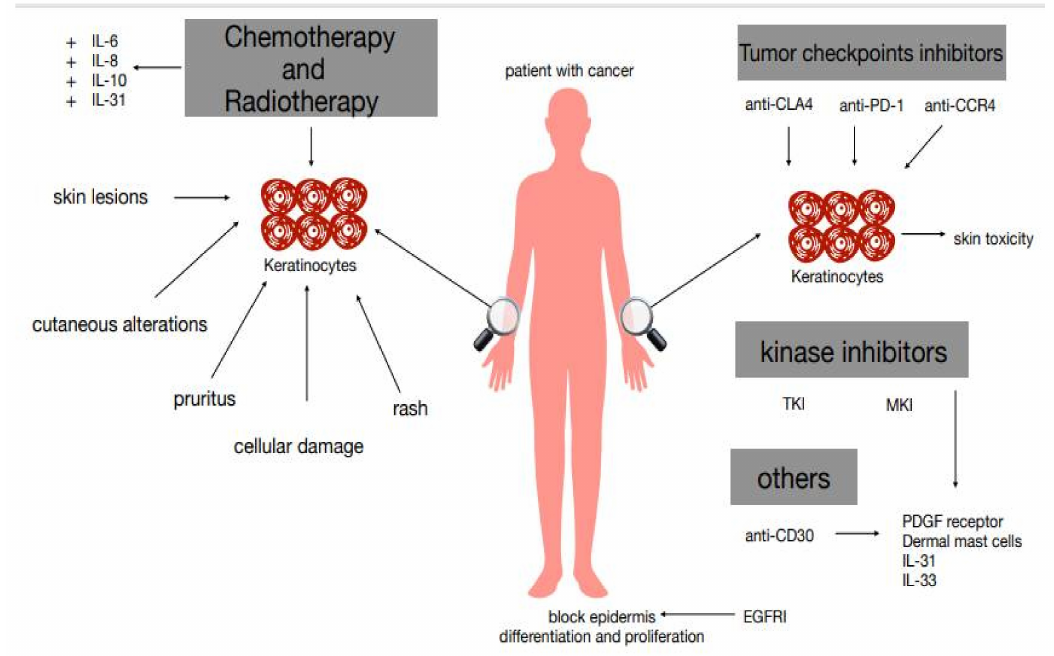
Figure 1. Possible mechanisms of cutaneous pruritus happening during cancer treatment. Antibodies against programmed cell death 1 (PD-1), a checkpoint in the effector phase of cytotoxic T cells, have been efficaciously employed in tumor immunotherapy. PD-1 blocks T-cell–mediated immune responses by attaching to its ligands, specifically PD-L1 and PD-L2. By avoiding the binding of PD-L to PD-1, some antibodies, such